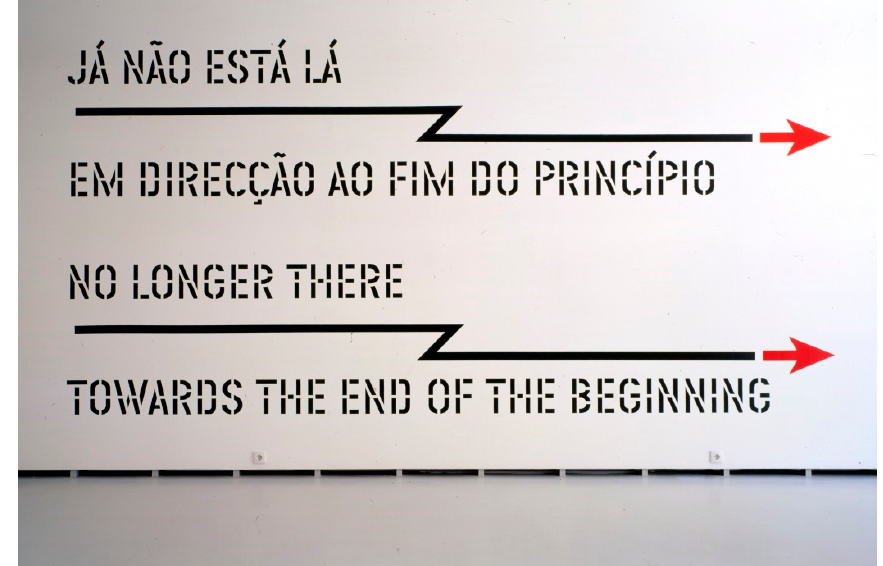
Figure 2. Cristina Guerra Contemporary Art. “Lawrence Weiner. Towards the End of the Beginning”, 2002. © Cristina Guerra Contemporary Art.